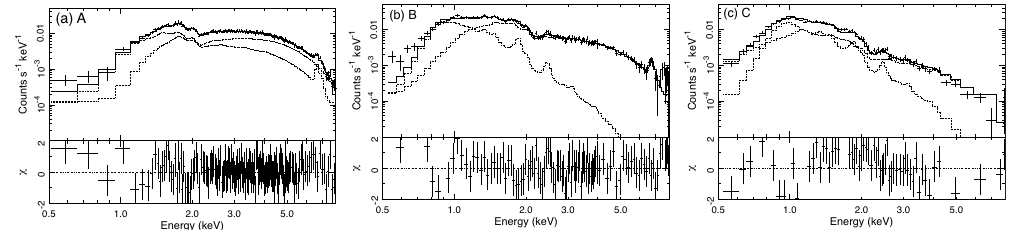
Figure 4: Composite spectra and the best-fit global model of the group (a) A, (b) B, and (c) C. The lower panel shows the residuals of the data to the fit. The best-fit parameters can be found in Table 1. Table 1: Best-fit Parameters for Global Spectral Model in 0.5–8.0 keV